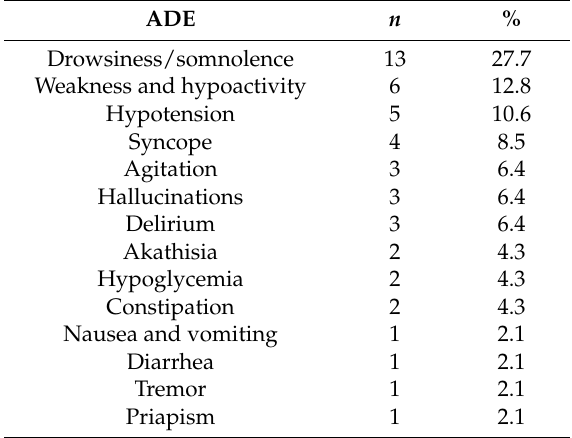
Table 3. Distribution of adverse drug events (ADEs), except falls.